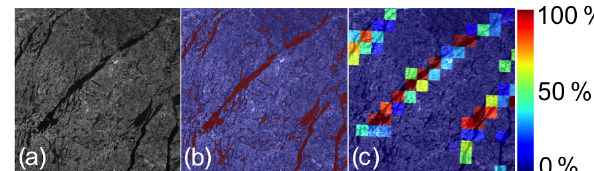
Figure 4. (a) A subset of the original SAR image (backscatter) on the 8 March 2009; (b) respective classified SAR image (red – lead, blue – ice) with (a) as background; (c) AMSR-E lead fraction in percent with (a) as background. Table 1. Number of measurements in the SAR LF data set. Month Subsets Measurements Nov